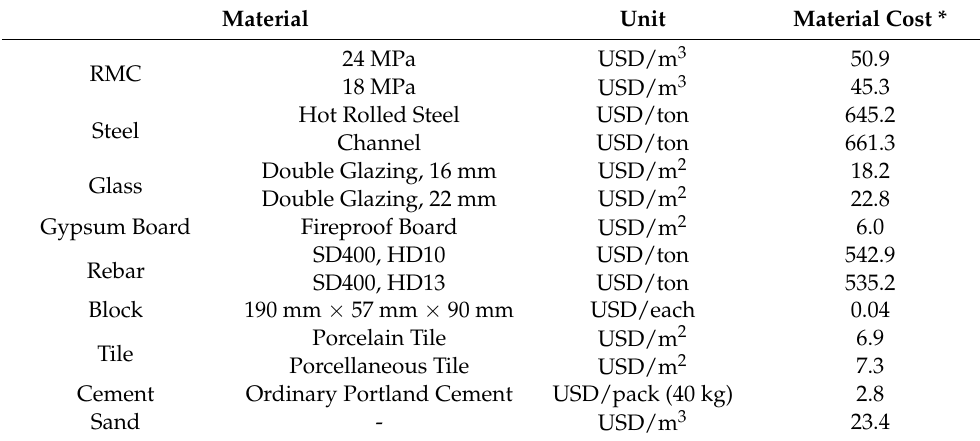
Table 4. Unit material cost of major construction